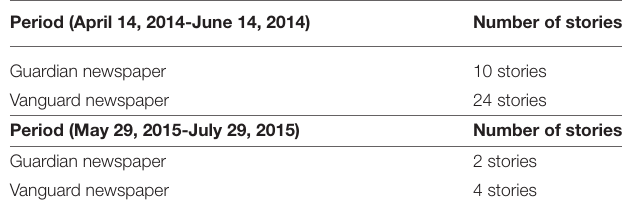
TABLE 1 | Storie’s breakdown from selected